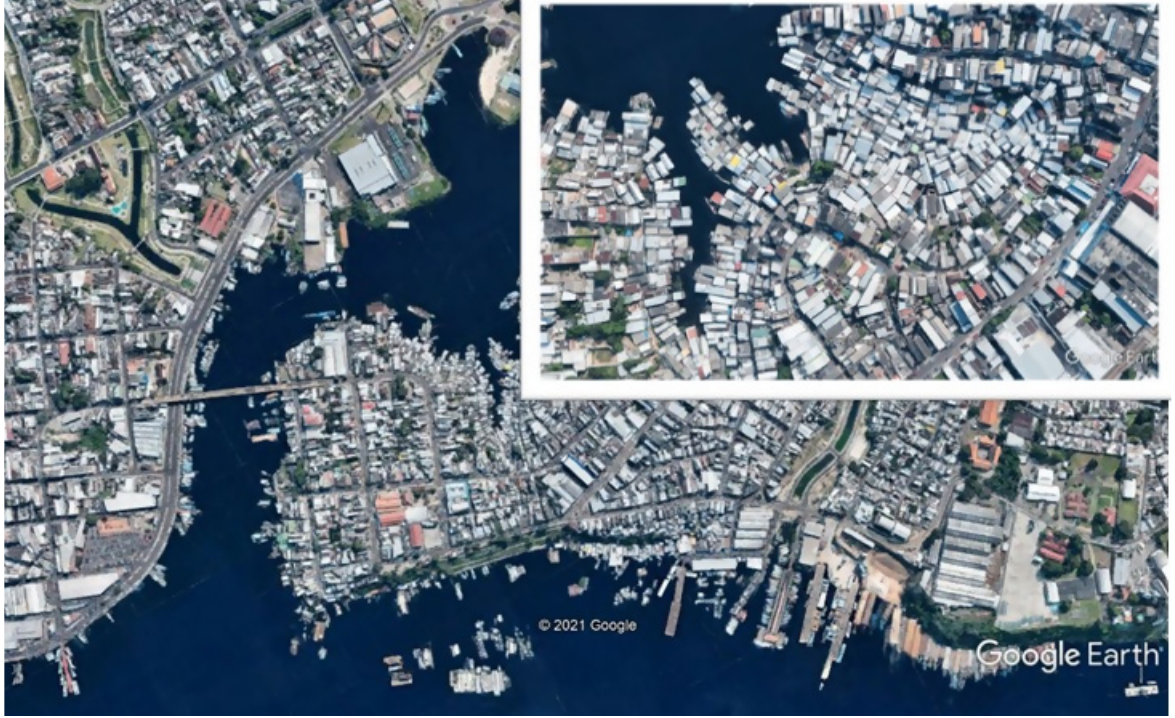
Figure 1. Large picture shows a channel reaching Negro river in Manaus, and some features of the urbanization around the harbour region. Detailed picture focused on a packed and convoluted under poverty neighbourhood, with floating houses in a small channel with stagnated water. An unlikely urbanization for effective social distancing and public areas cleaning. Obtained from Google